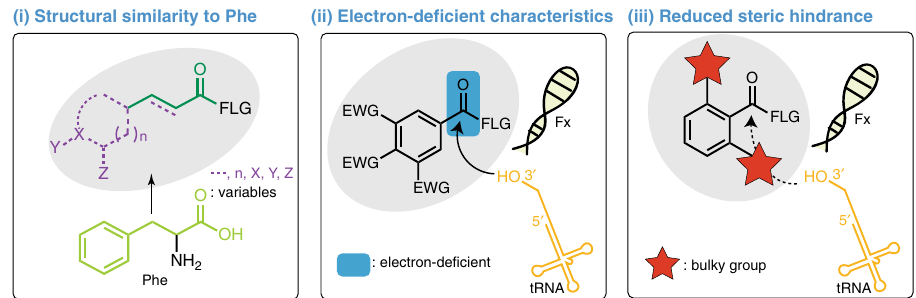
Fig. 3 General substrate design rules for fl exizyme tRNA-charging. Substrates with structural similarity to Phe, electron-de fi cient characteristics, and reduced steric hindrance around the carbonyl group show high compatibility with the fl